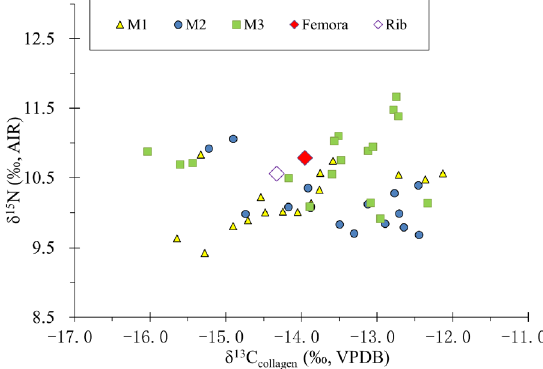
Figure 4. Scatter plot of δ 13 C and δ 15 N values of collagen for femur, rib and dentin serials.